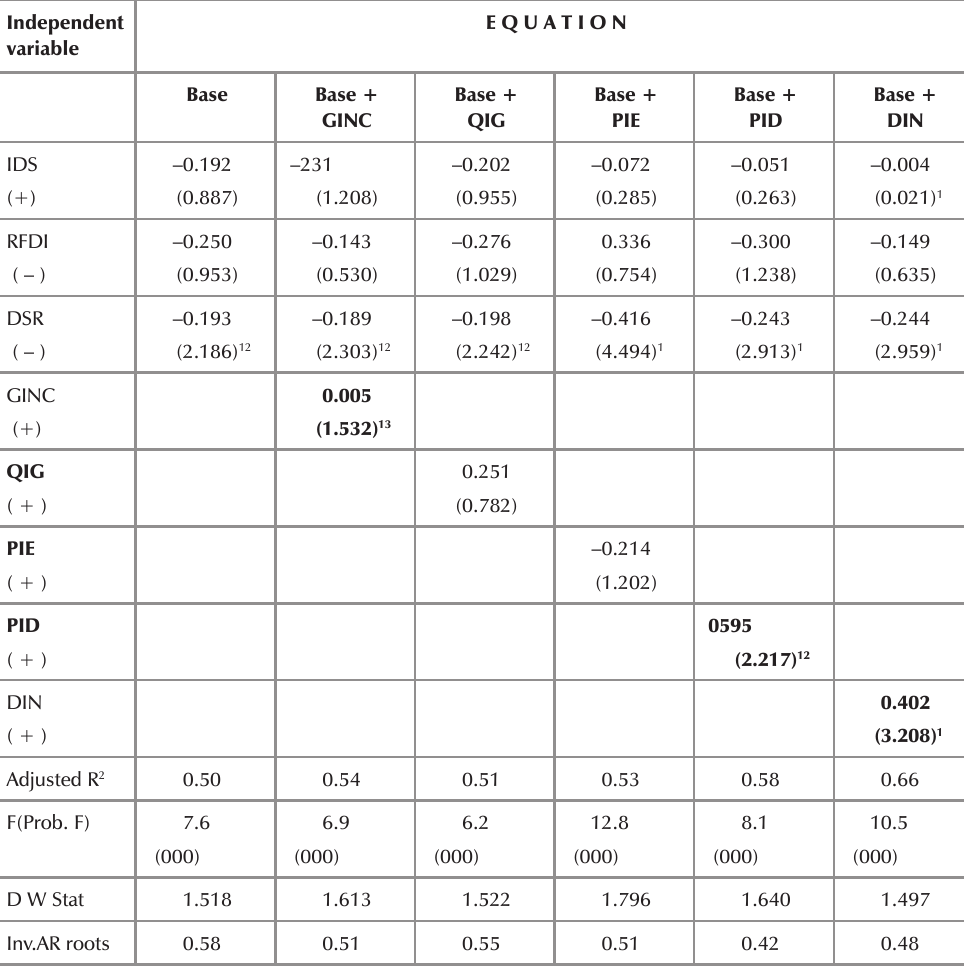
Regression of gross domestic savings in real terms on the level of